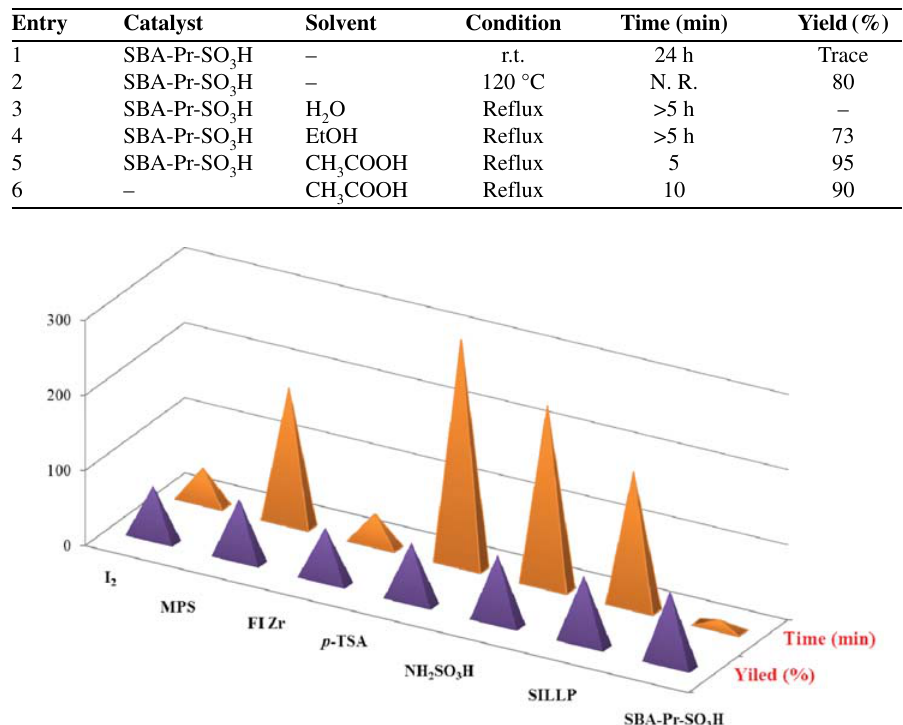
Figure 1. Comparison of reaction times and product yields for the synthesis of 4 using different catalysts including I (MPS), 12 p -toluenesulfonic acid ( p -TSA), 13 NH